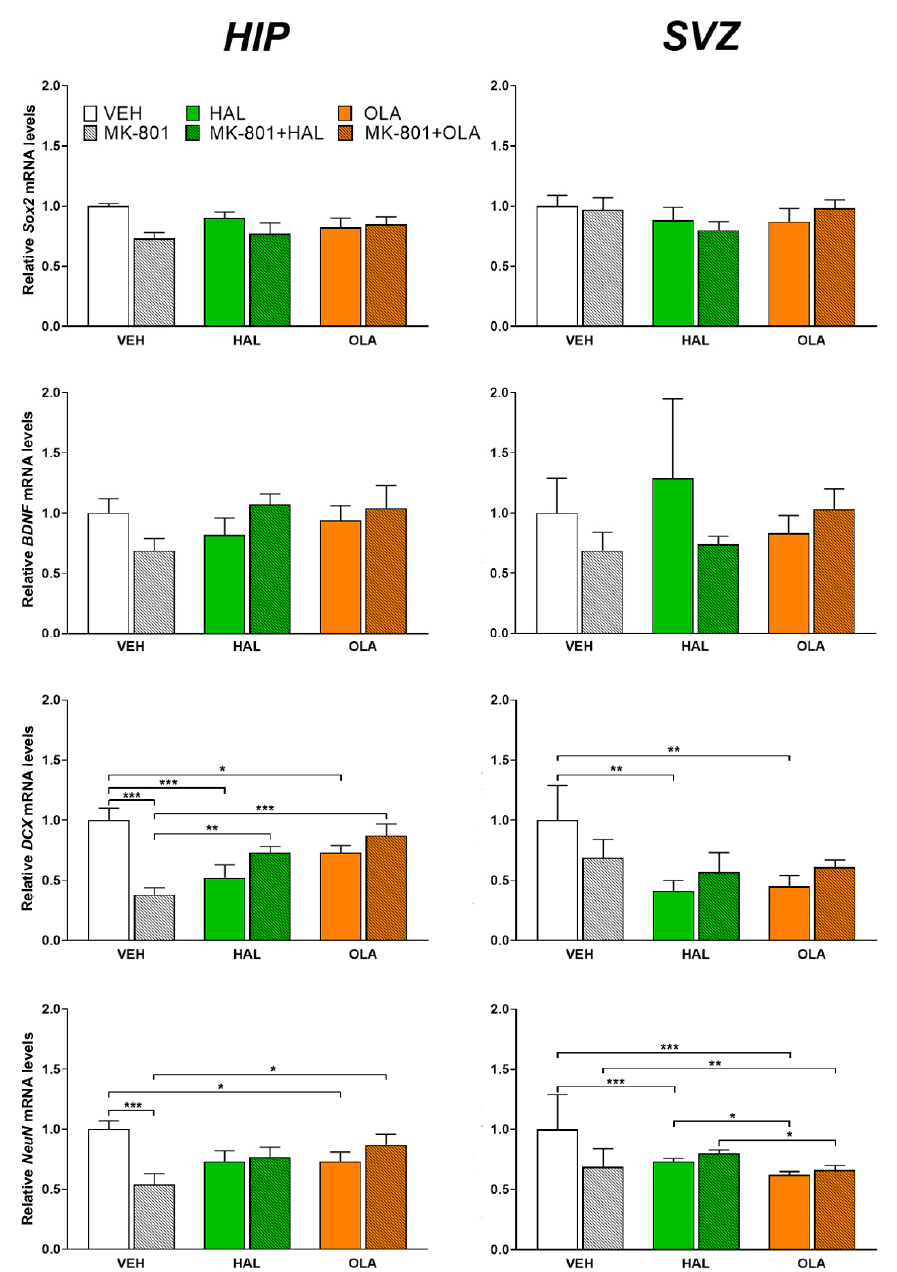
Figure 3. Relative Sox2 , BDNF , DCX , and NeuN mRNA levels in the HIP and SVZ. Data are presented as fold change relative to control, taken as 1 (mean ± SEM, n = 7 animals pre-group). * p < 0.05, ** p < 0.01, *** p < 0.001.